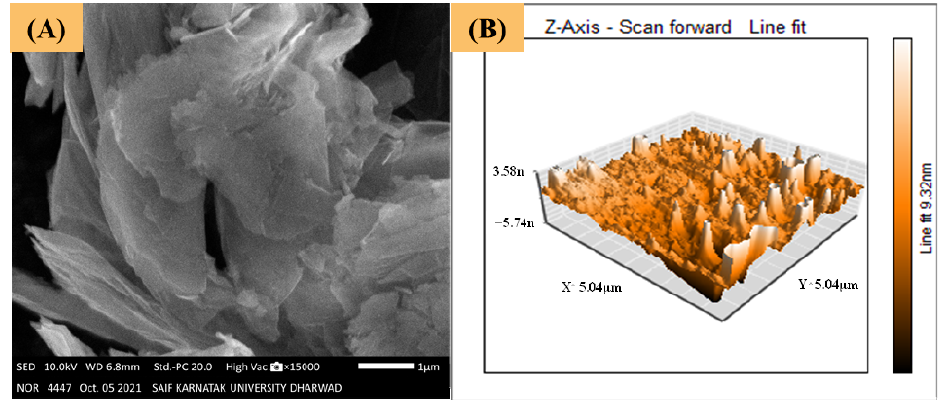
Figure 1. Surface topography and morphology of a modifier: ( A ) SEM image and ( B ) AFM image of the graphene matrix.